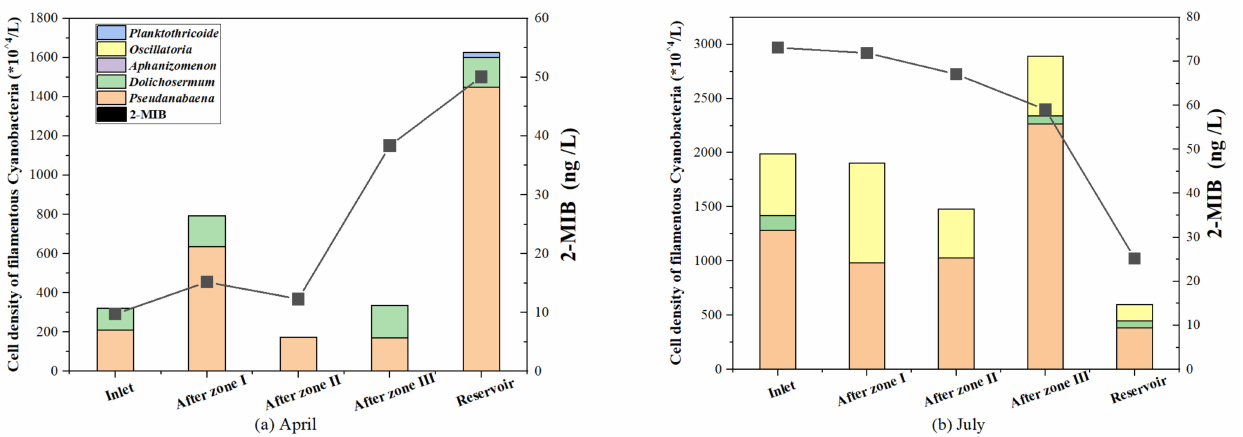
Figure 6. Double Y plots of the cell densities of five filamentous cyanobacteria and 2-MIB concentra- tion along the four treatment zones in April ( a ) and July ( b